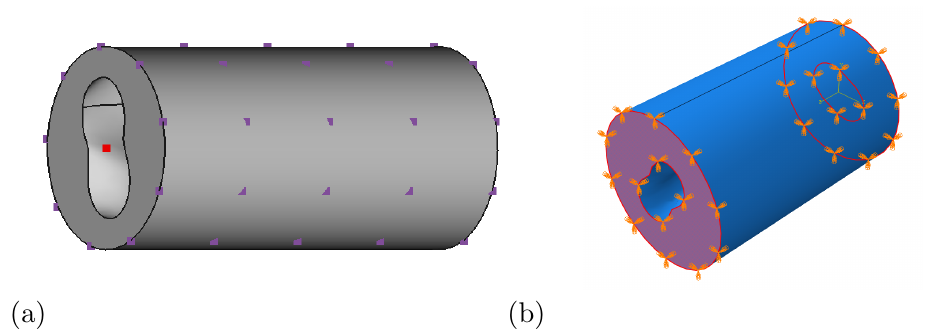
Figure 3. Used parametric model of roll geometry with control points shown in purple ( a ) and boundary conditions applied in the simulation with fixed displacements of nodes at the end cross- sections ( b